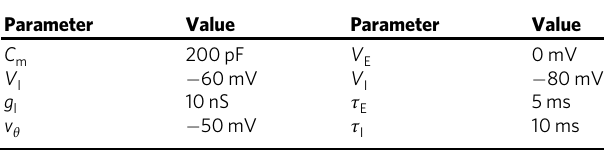
Neuron model . Neurons were modelled as conductance-based spiking leaky integrate-and- fi re neurons. Their membrane potential evolves according to: